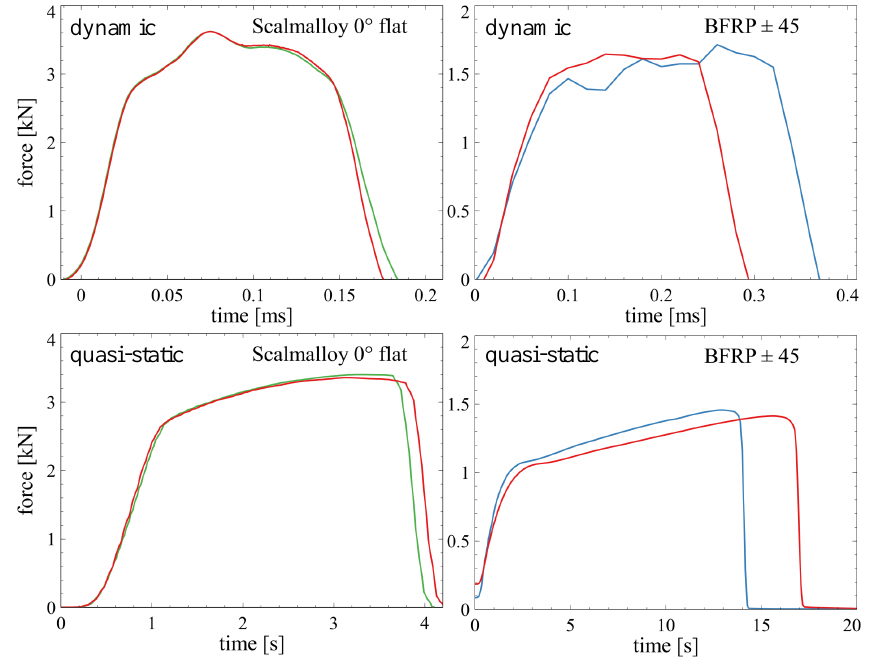
Figure 8. Force analysis of Scalmalloy (printed 0° flat) and Basalt Fibre BFRP (fibre direction ± 45°) under tension in dynamic and quasi-static tension experiments. All results presented here, are a set of two